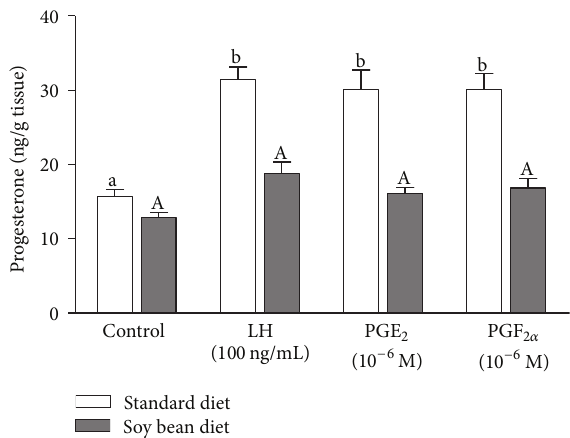
Figure 5: The effect of soybean diet on the LH-, PGE 2 -, and PGF 2𝛼 - stimulated in vitro progesteronesecretionbythebovineCL(adapted from Piotrowska et al.,